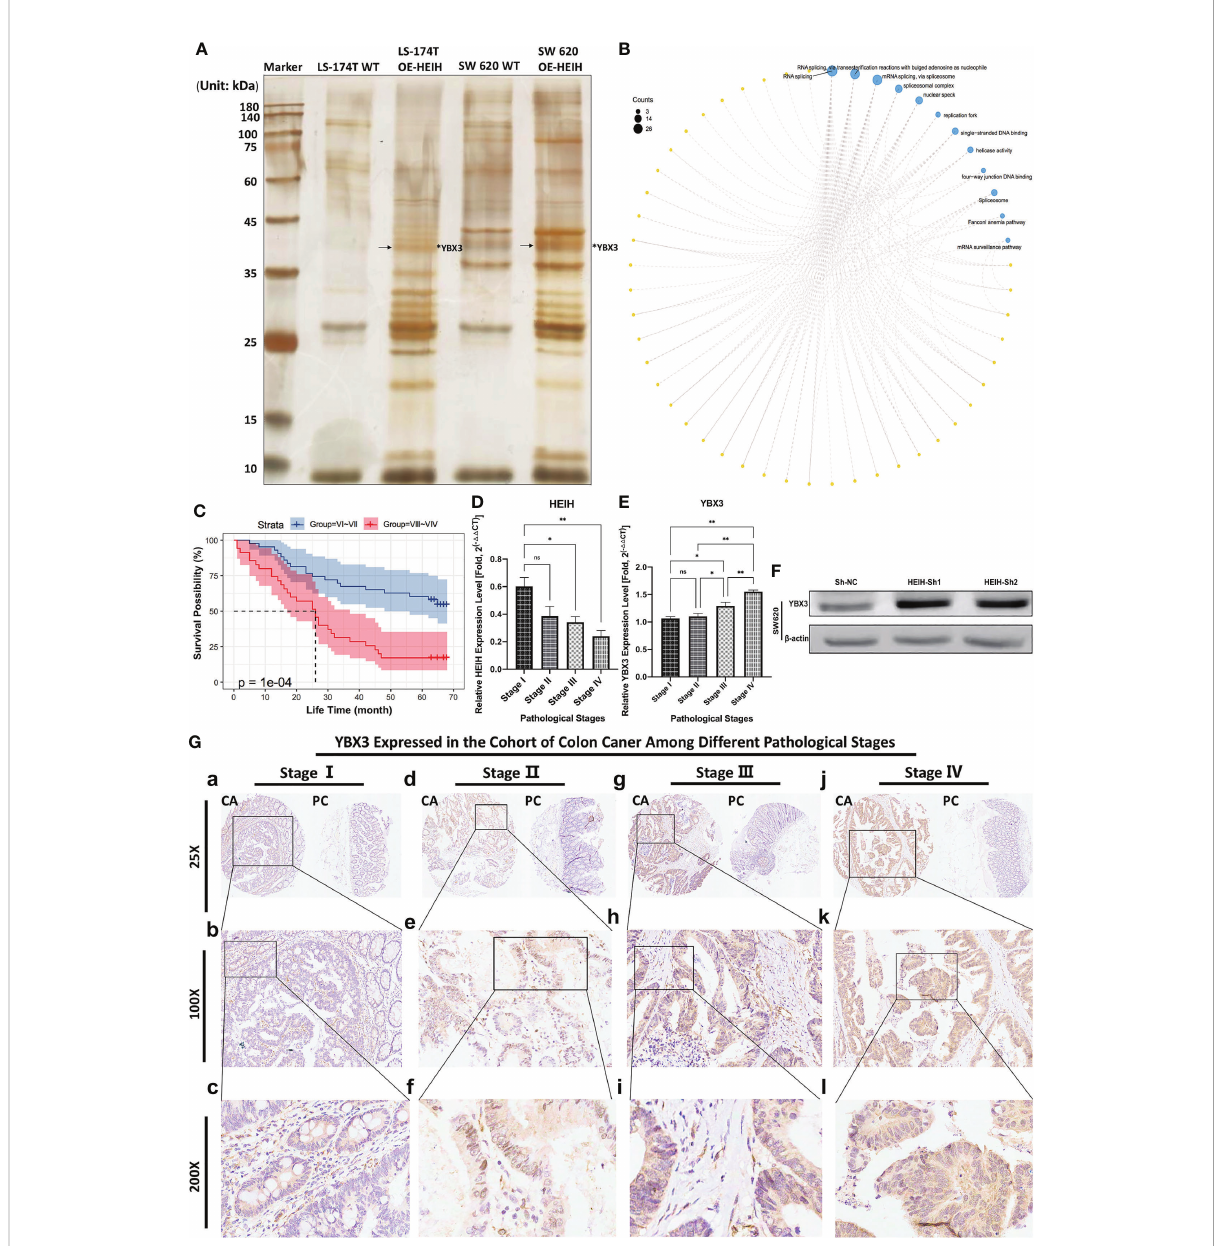
FIGURE 7 Experimental veri fi cation of the combination and role of HEIH/YBX3 in colon cancer. (A) lncRNA HEIH pull-down. (B) Enrichment analysis of the pulled-down proteins. (C) Correlation between YBX3 expression in diverse clinical stages and prognosis in the colon cancer cohort. (D) HEIH expression level in various cancer stages quanti fi ed by qPCR. (E) YBX3 expression level in various cancer stages quanti fi ed by qPCR. (F) In SW620 cell line, lncRNA-HEIH knockdown enhanced the YBX3 expression con fi rmed by western blot. (G) Immunohistochemical staining of tissue microarray showing the YBX3 expression in different clinical pathological stages in magni fi cations of ×25, ×100, and ×200, respectively. *P<0.05; **P<0.01; ns, non-signi fi